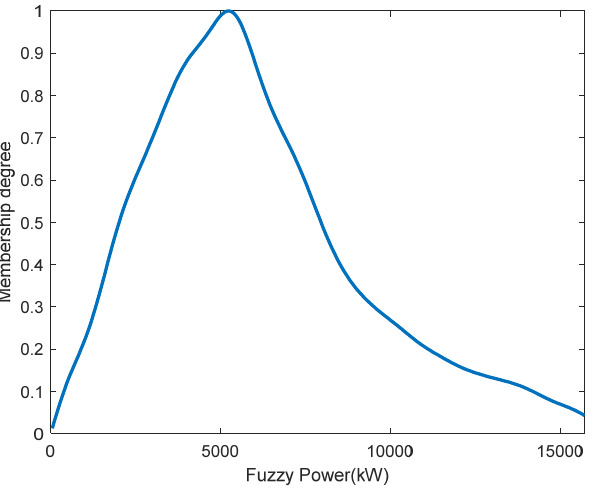
Figure 4. The fuzzy power generation 𝛼(cid:3556) (cid:2871),(cid:2871) .